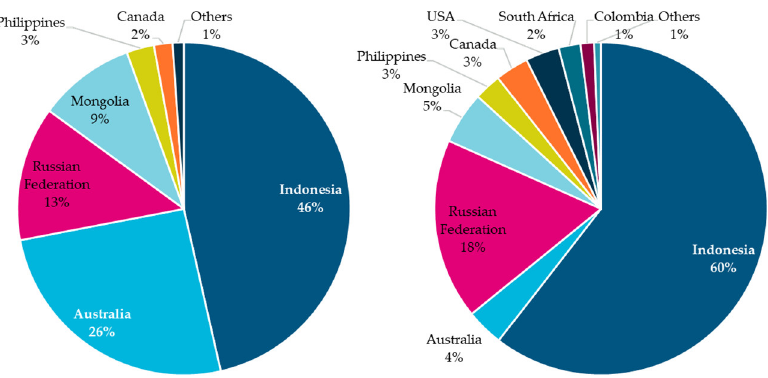
Figure 6. Major trading partners for China’s imports of coal in 2020 ( left ) and 2021 ( right ). Source: General Administration of Customs, P.R.China.